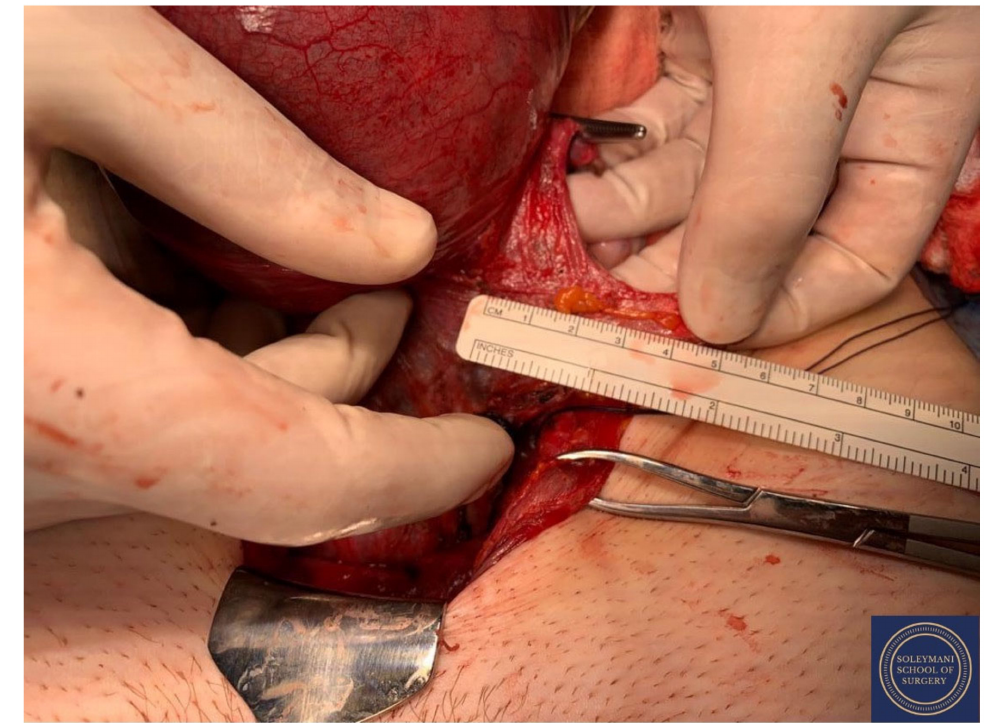
Figure 13. Complete dissection of the left